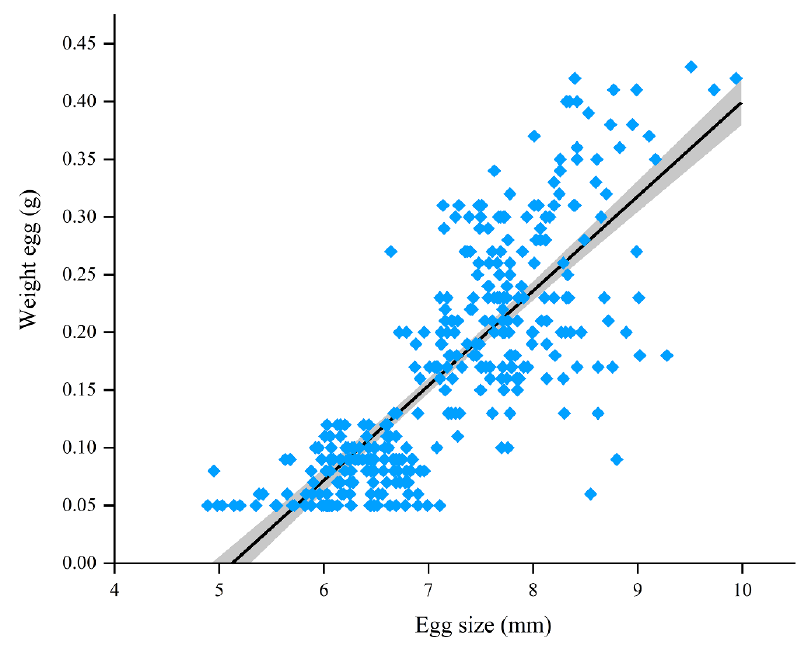
Figure 6. A positive linear correlation between size (mm) and weight (g) of fish eggs (black line), Figure 6 . A positive linear correlation between size ( mm ) and weight ( g ) of fish eggs ( black line ) , r = r = 0.801, p < 0.01, n = 0 . 801, p < 0 . 01, n = 349 .